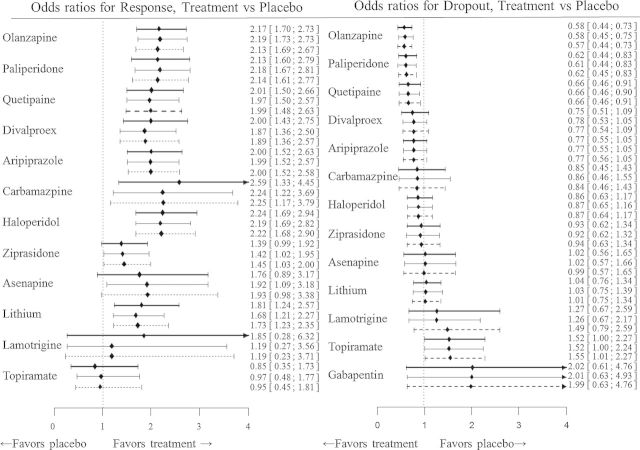
Summary odds ratios for response and dropout, for active treatment versus placebo. The thick lines correspond to model I (univariate model), the slim lines to model II.b (MONMA model assuming strong correlation coefficient \documentclass[12pt]{minimal}
\usepackage{amsmath}
\usepackage{wasysym} 
\usepackage{amsfonts} 
\usepackage{amssymb} 
\usepackage{amsbsy}
\usepackage{upgreek}
\usepackage{mathrsfs}
\setlength{\oddsidemargin}{-69pt}
\begin{document}
}{}$\rho \sim U(-0.7,-0.5)$\end{document}) and the dashed lines to model III (alternative MONMA model assuming \documentclass[12pt]{minimal}
\usepackage{amsmath}
\usepackage{wasysym} 
\usepackage{amsfonts} 
\usepackage{amssymb} 
\usepackage{amsbsy}
\usepackage{upgreek}
\usepackage{mathrsfs}
\setlength{\oddsidemargin}{-69pt}
\begin{document}
}{}$\rho ^{\mathrm {h}}\sim U(-1,0)$\end{document}.